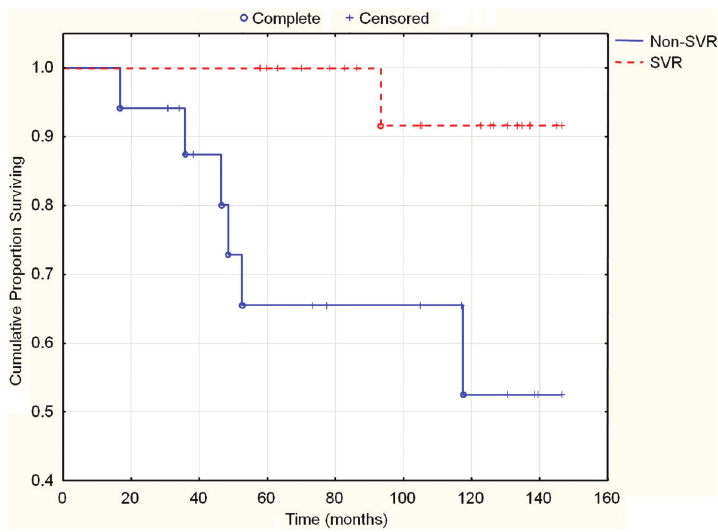
Figure 3. Cumulative survival (Kaplan-Meier) of patients who had recurrent hepatitis C viral (HCV) infection after orthotopic liver transplantation with sustained virological response (SVR) versus non- SVR. Survival was signi fi cantly better in those who achieve SVR after recurrent HCV therapy (P o